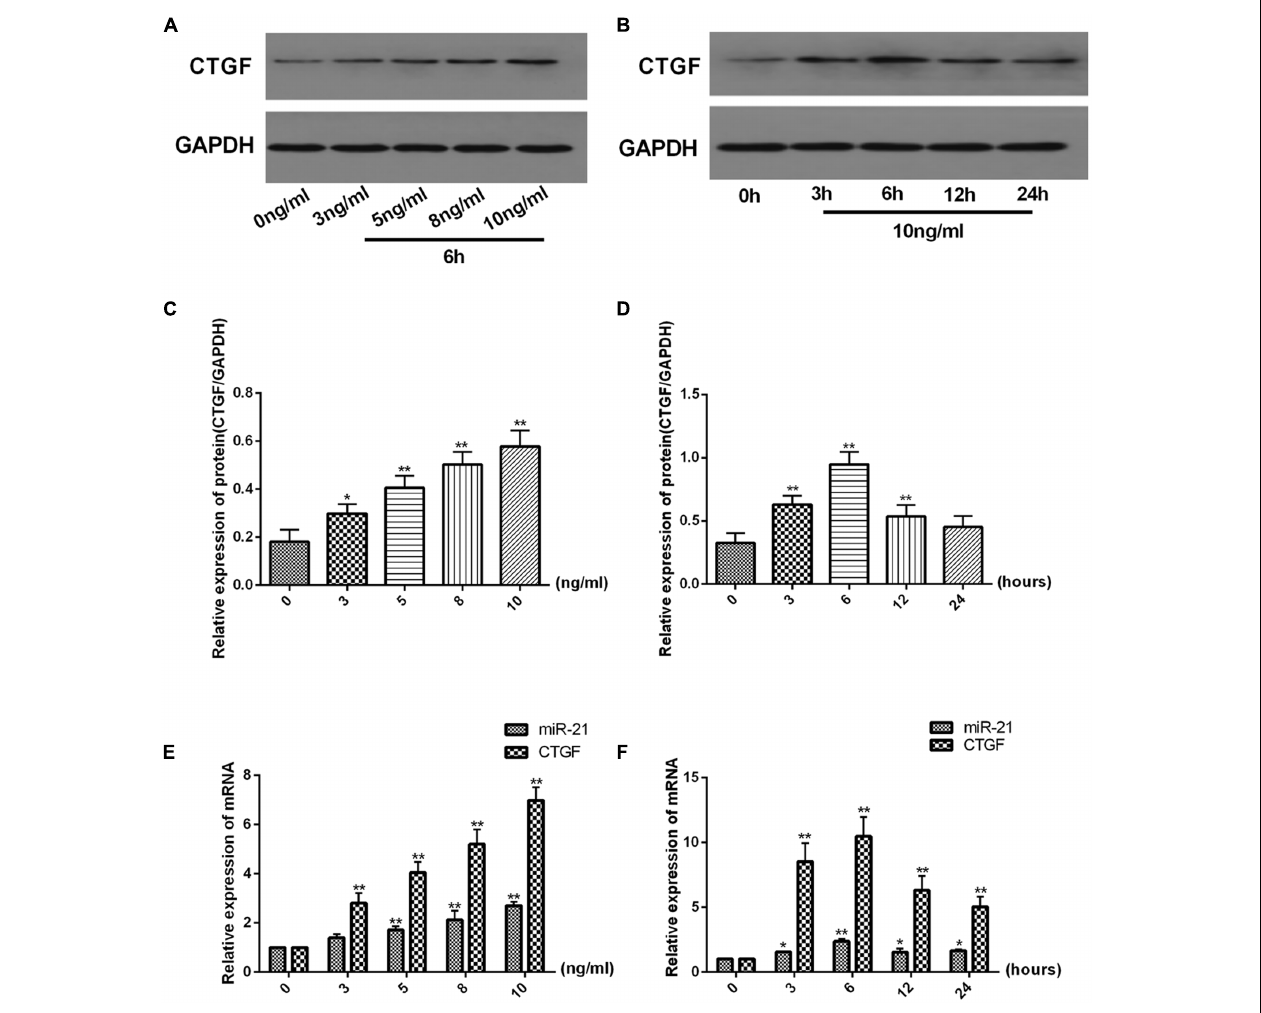
FIGURE 2 | TGF- β 1 increases miR-21 and CTGF expression in a dose-dependent manner and decreases it in a time-dependent manner. (A,B) The protein levels of CTGF were measured by western blot. (C,D) The ratio of CTGF to GAPDH was obtained by densitometric analysis. (E,F) The mRNA levels of miR-21 and CTGF were detected by real-time quantitative PCR. Data are shown as the means ± SD. ∗ P < 0.05, ∗∗ P < 0.01. compared with either time point 0 or the untreated